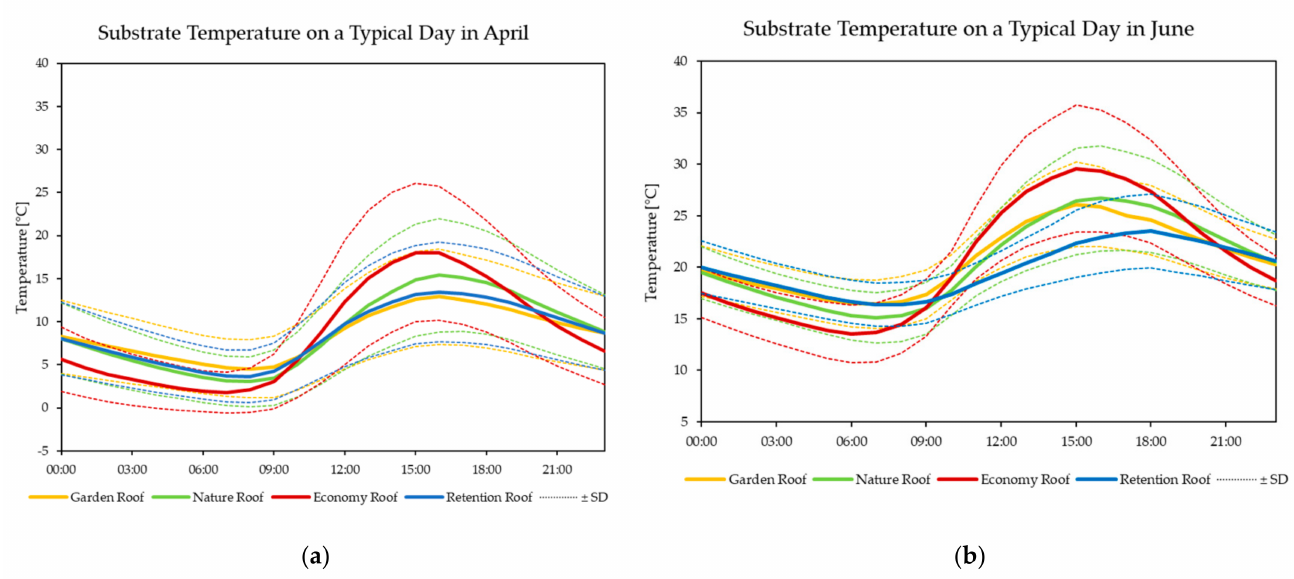
Figure 10. Substrate temperatures on an average day of the four different green roofs in: ( a ) April; ( b ) June. For each single day in April and June, the raw data were aggregated to 24-hourly means. Shown are means ± SD for each hour of 30 days in April and June, respectively (n =